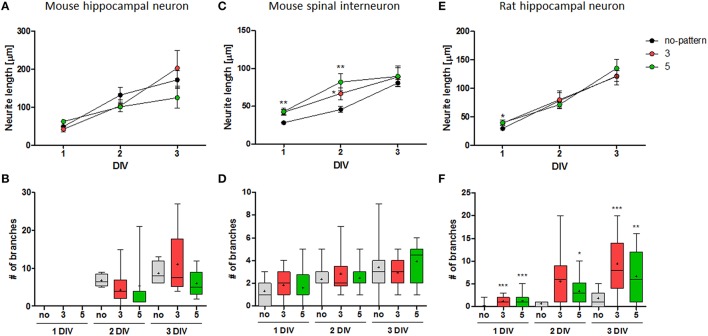
Cell-type specific growth on microdot arrays. (A,B) The neurite length (A) and branch number (B) of mouse hippocampal neurons on control substrates (black), microdot arrays with 5 μm diameter and 3 (red) or 5 μm (green) spacings (adapted from Kim et al., 2014). (C–F) The neurite length (C,E) and branch number (D,F) of mouse spinal interneurons (C,D) and rat hippocampal neurons (E,F) on control substrates and the same conditions of microdot arrays (mean ± SEM; *p < 0.05, **p < 0.01, ***p < 0.001 under Mann-Whitney test; (B,D,F) box plots with min-max whiskers, +: mean).